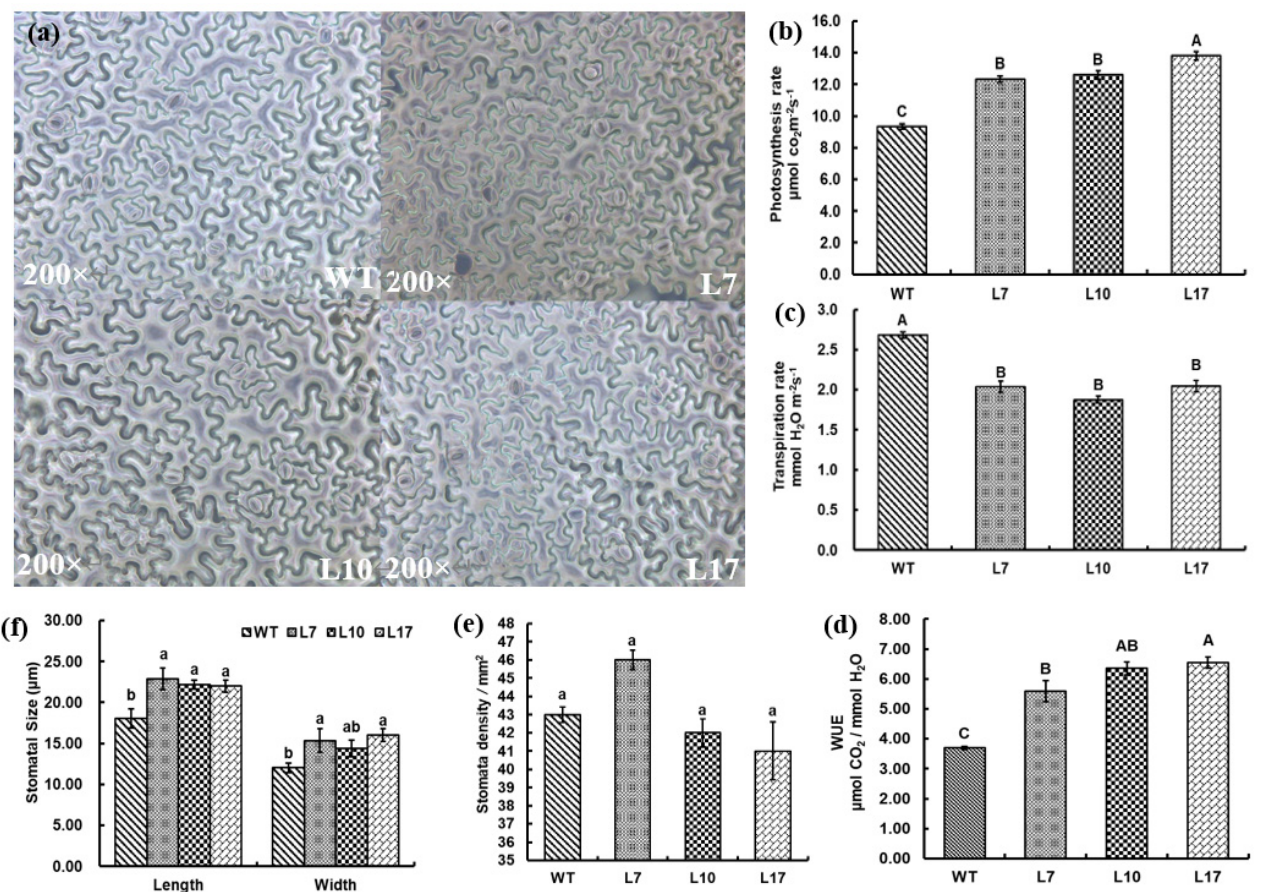
Figure 8. Stomatal density ( a , e ), stomatal size ( f ), photosynthesis rate ( b ), transpiration rate ( c ) and water-use efficiency (WUE) ( d ) in transgenic (L7, L10, and L17) and WT tobacco lines. Lowercase letters indicate a significant difference at the 5% level. Capital letters indicate a significant difference at the 1% level.